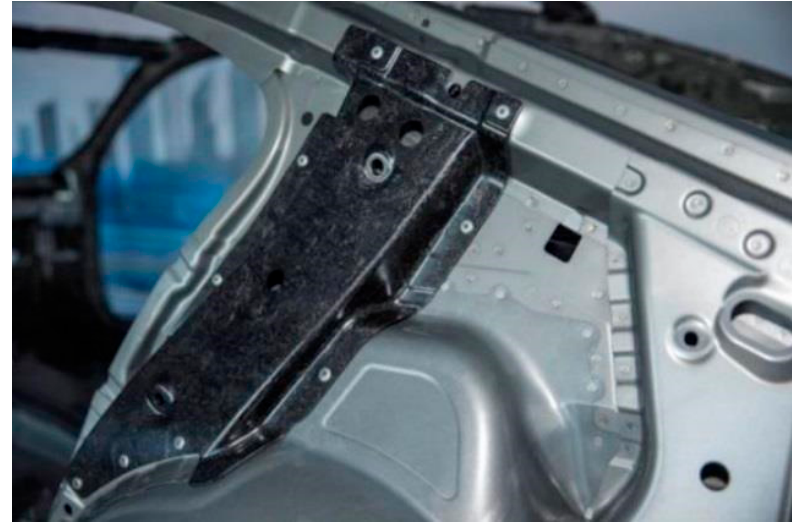
Figure 1. C-pillar within BMW 7 series from sheet molding compound (SMC).